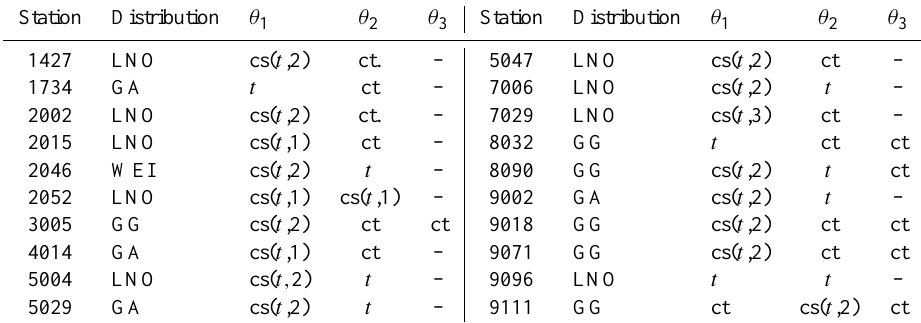
Table 4. Summary for the fitted models type 1 and the type of dependence between time and the distribution parameters: cs( · ) indicates the dependence is via the cubic splines with the indicated degree of freedom; without cs( · ) means linear dependence; and ct refers to a parameter that is constant.